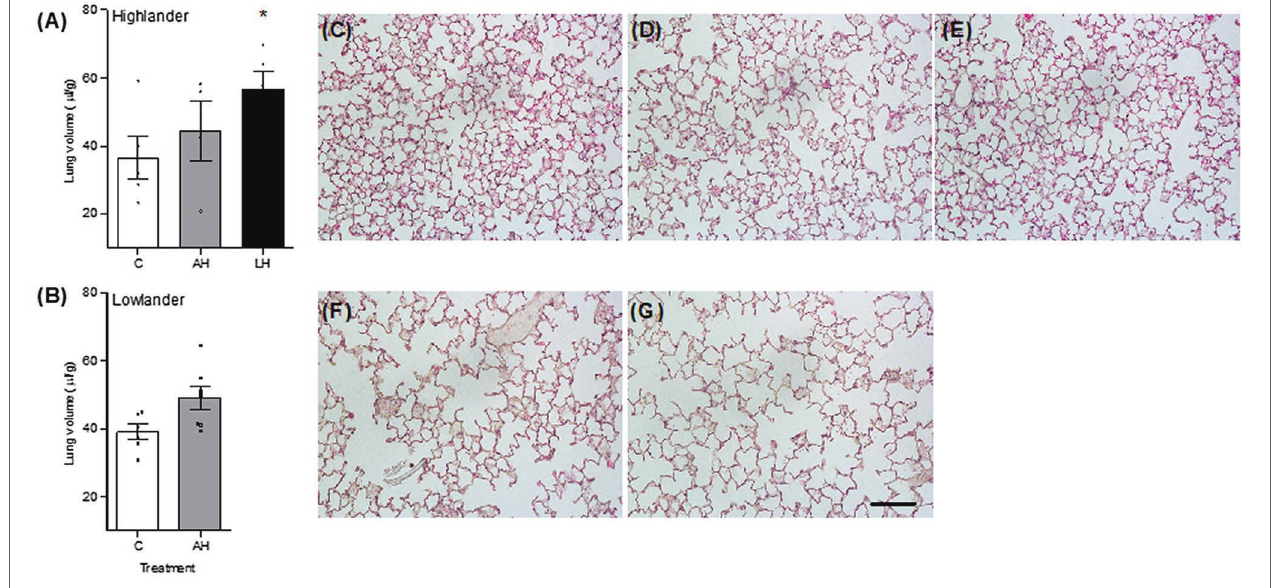
FIGURE 5 | Developmental hypoxia increased lung volume (A,B) . Lung parenchyma structure was preserved between control (C; C,F ), adult hypoxia (AH; D,G ), and life-long hypoxia (LH; E ) treatment groups in highlanders (C–E) and lowlanders (F,G) . Bars indicate mean ± SEM and symbols represent individual values. Treatment groups are shown in Figure 1 with N as follows: five C, four AH, and five LH for highlanders; six C and seven AH for lowlanders. Each image has the same scale, and the scale bar represents 100 μ m. Lung morphometrics are reported in Table 2 . *Significant pairwise difference from control within each population using Holm-Sidak